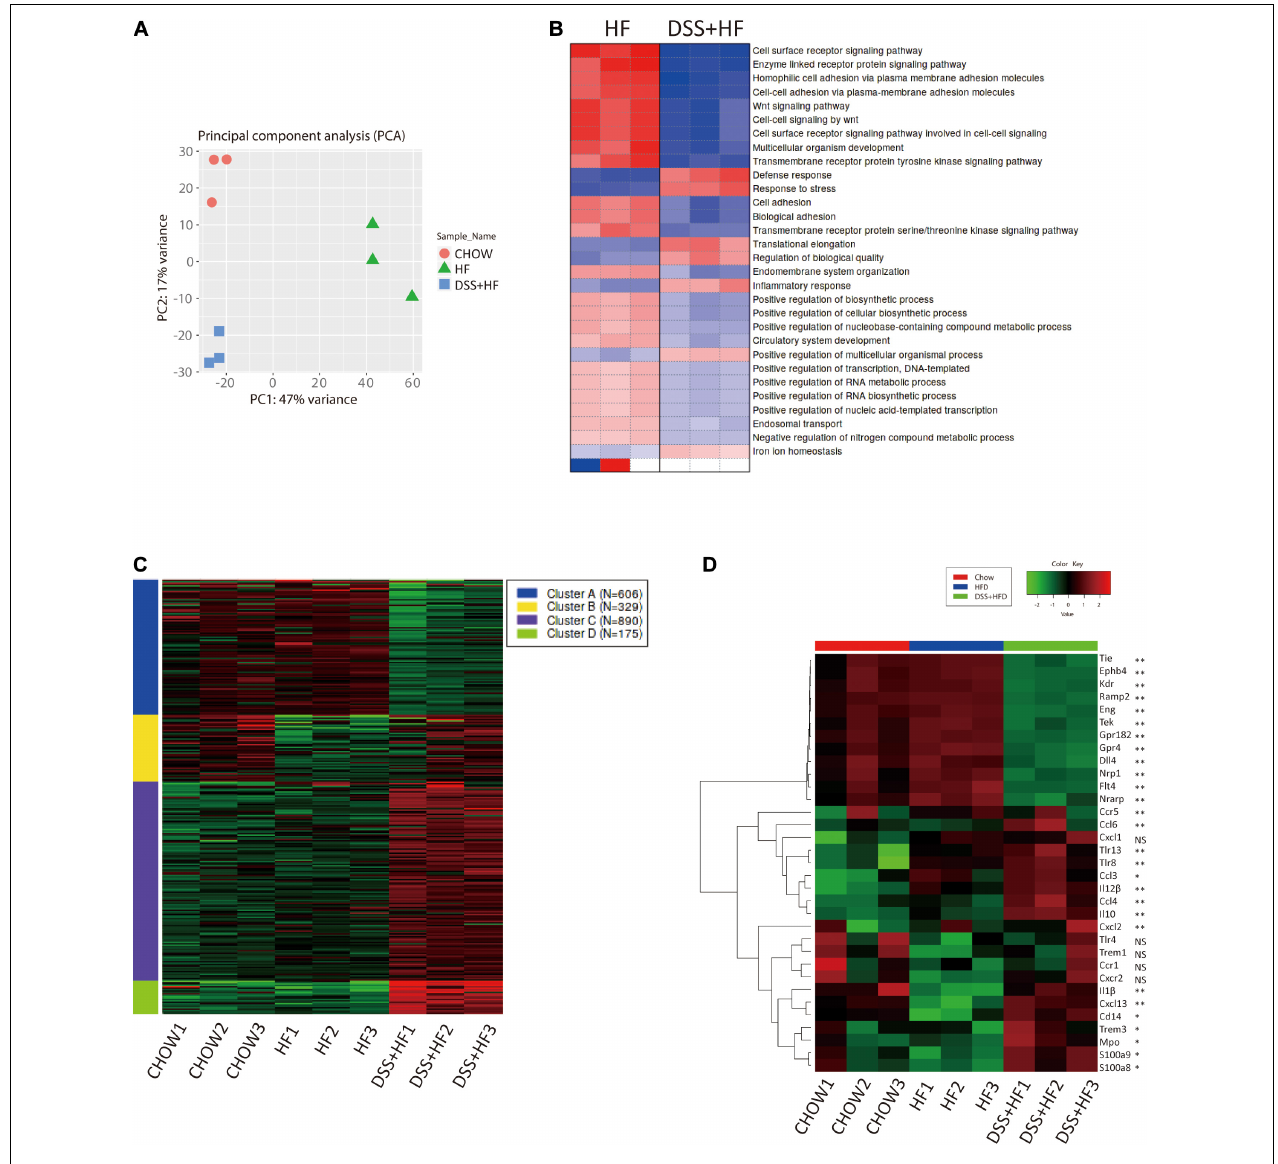
FIGURE 4 | Gene expression profiles of liver non-parenchymal cells related to DSS treatment. (A) Principal component analysis (PCA) of chow, HF and DSS + HF group. (B) Heatmap of GO terms enriched for HF and DSS + HF groups. All P values in the GO enrichment analysis were adjusted for multiple testing using the BH method. Adjusted P < 0.05 was considered significant. (C) Genewise clustering heatmap of 2000 DEGs according to the gene expression patterns, showing segregation into four clusters. (D) Heatmap of the representative DEGs that are shared by Chow vs. HF vs. DSS + HF comparisons and enriched for “vascular